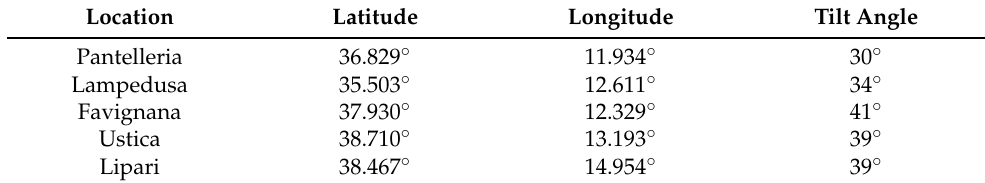
Table 1. Optimal tilt angle by PVGIS